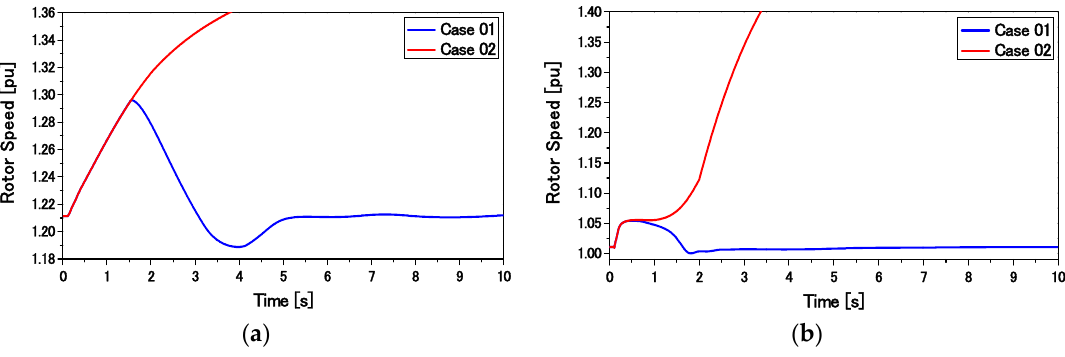
Figure 26. Rotor speed response of wind generators: ( a ) DFIG; ( b ) SCIG.